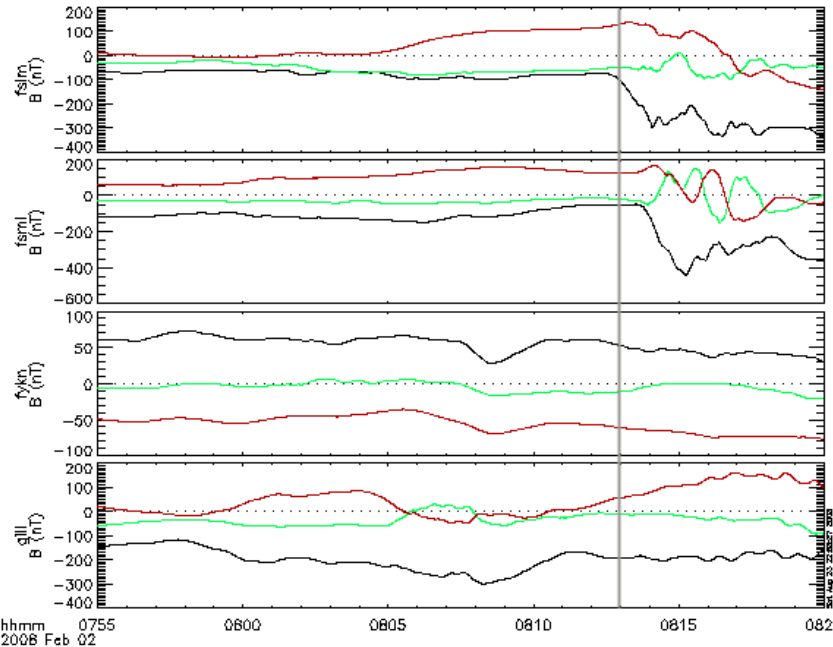
Figure 13. Ground magnetometer data B x , B y and B z (black, green and red) associated B x , B y and B z (black, green and red) associated with the second ∼ 08:12 with the second ~ 8:12 event. Fig. 13. Ground magnetometer data